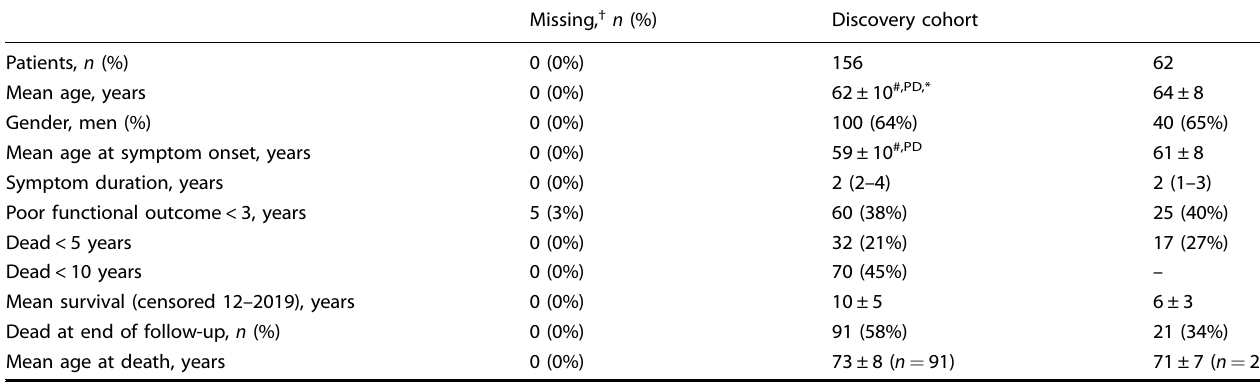
Table 1. Characteristics of discovery and validation